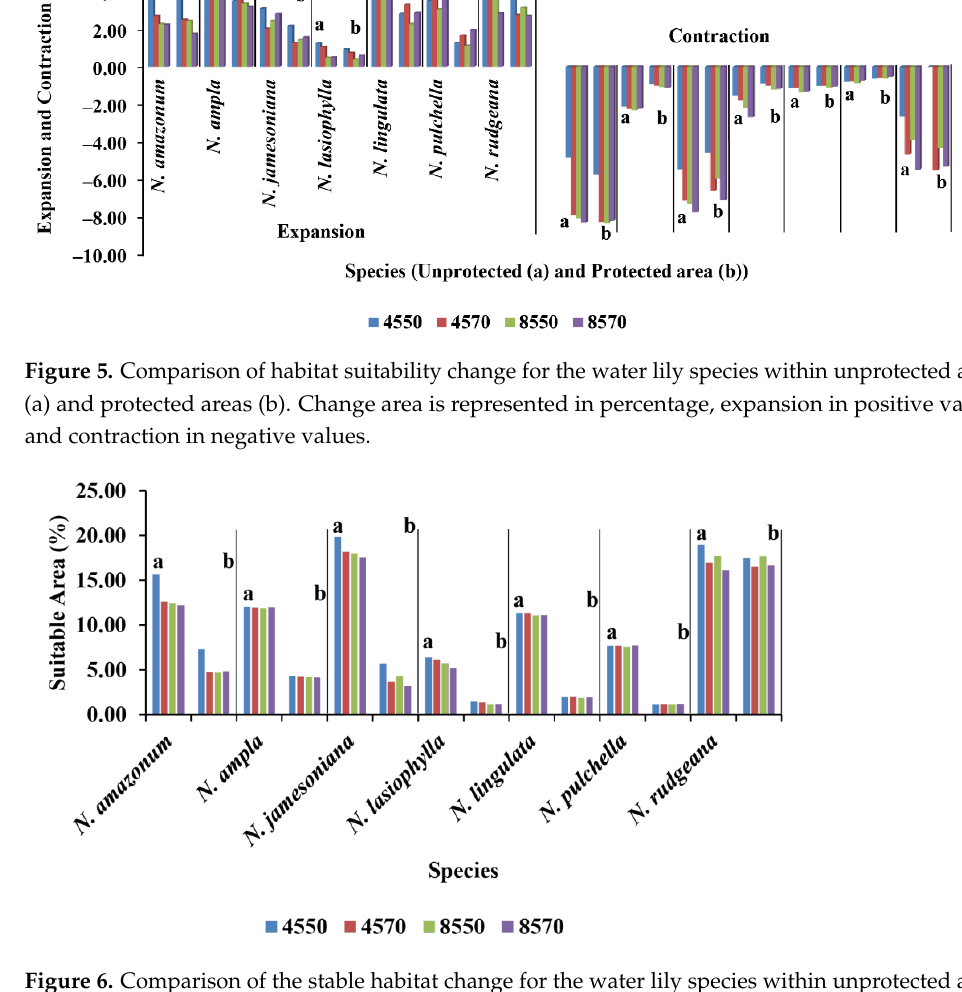
Figure 6. Comparison of the stable habitat change for the water lily species within unprotected areas (a) and protected areas (b). Change area is represented in percentage.